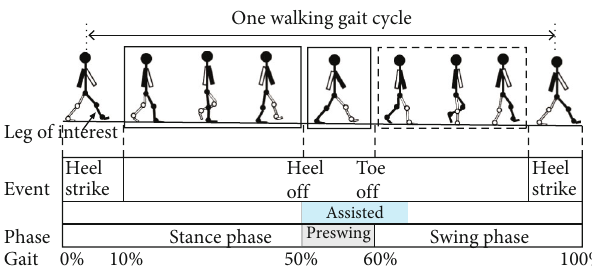
Figure 1: Illustration of the assistance provided by a lower-limb soft exoskeleton during a walking gait cycle in which assistive forces were supplied for hip fl exion during the preswing